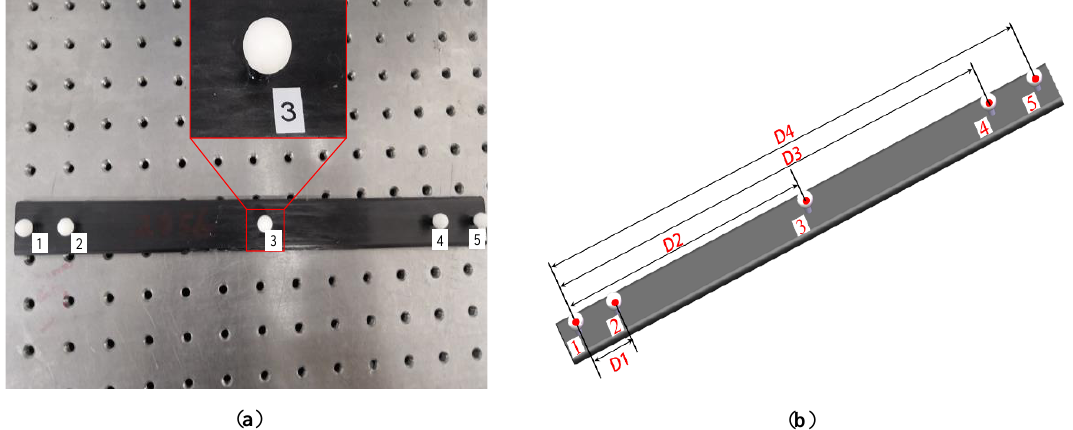
Figure 11. Metric tool for accuracy verification: ( a ) standard ruler; ( b ) distance between the centers of each pair of spheres.